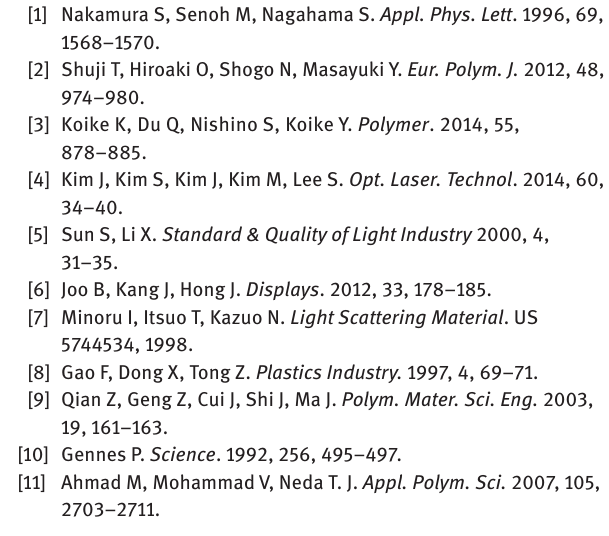
Figure 15: The effect of the content of prepolymer (St) on transmittance of the sample.